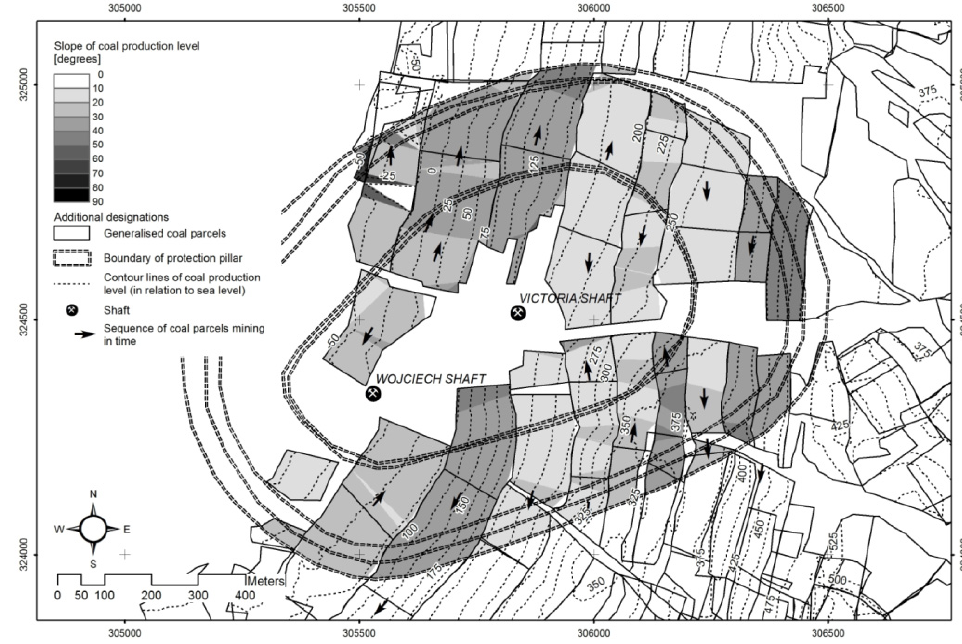
Figure 11. Slope analysis for the 424/425 coal production level within the boundaries of the protection